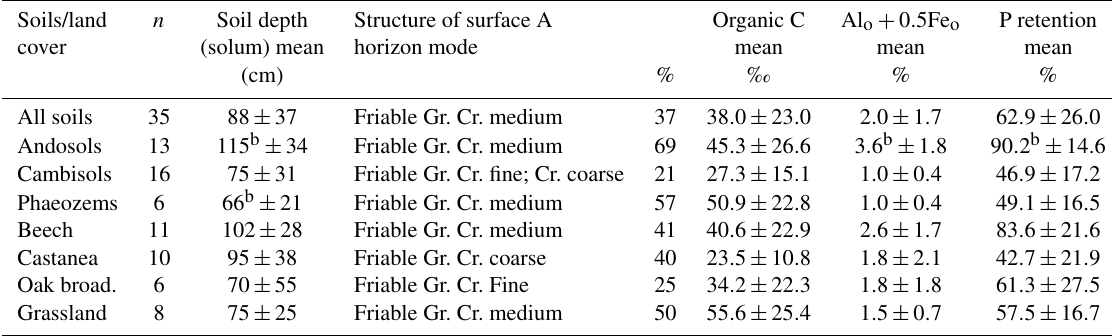
table refers to soil types (IUSS Working Group WRB, 2015) and the lower part refers to land cover (CORINE Land Cover classes by APAT, 2000) after site validation. NDVI MODIS metrics refer to a whole 2003, 2005, 2014 time series (16-day step). Table 2. Main features of the studied soils.